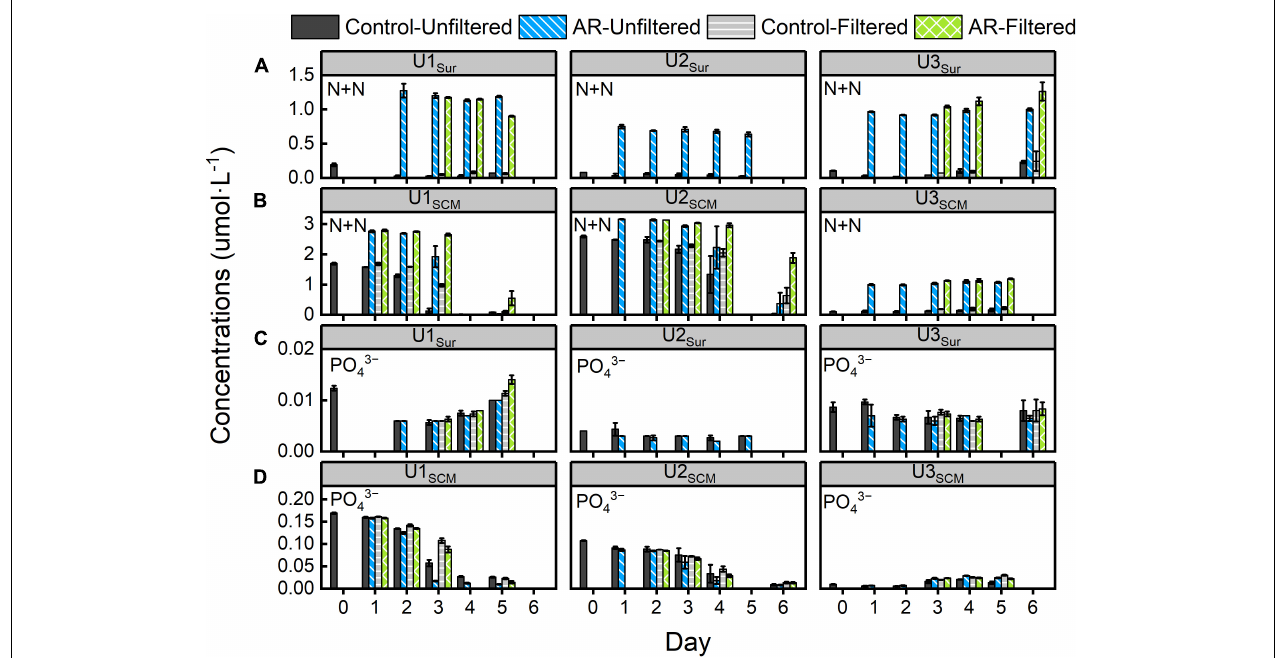
FIGURE 2 | Changes in panels (A,B) N + N and (C,D) PO 43 - concentrations in the control and anthropogenic aerosol (AR) treatments incubated with surface and subsurface chlorophyll a maximum (SCM) seawaters. The error bar represents the standard deviation of three parallel